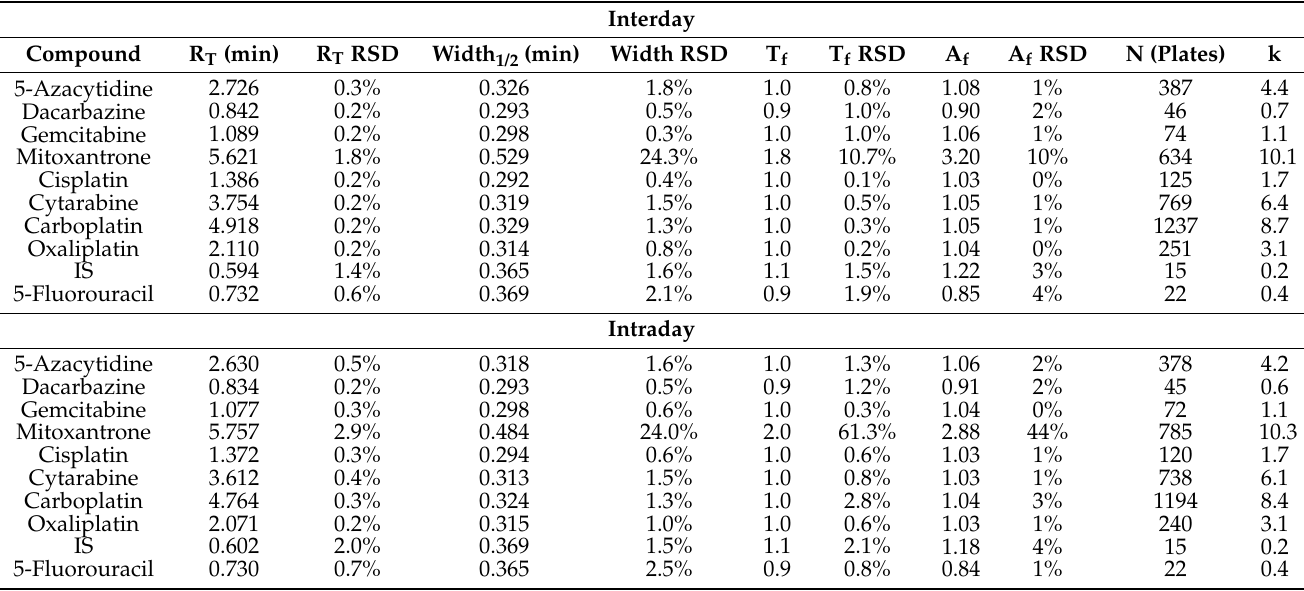
Table 2. Show the analytes retention time (RT) and their relative standard deviation (RSD), the calculated plates number (N), and the retention factor